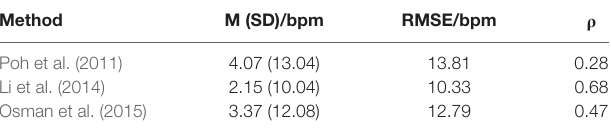
table 3 | Obtained performance for the complete methods.